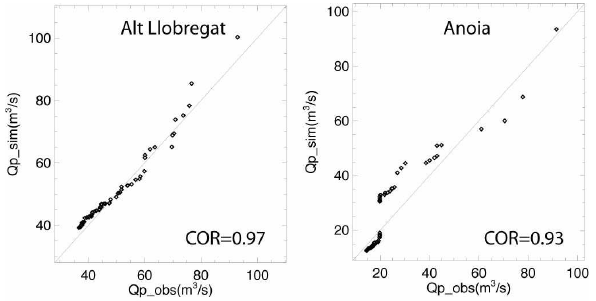
Figure 4 Comparison between observed and simulated peak discharge for alt Llobregat basin 2 Fig. 4. Comparison between observed and simulated peak discharge (on the left) and Anoia basin (on the right). 3 for Alt Llobregat basin (on the left) and Anoia basin (on the right).